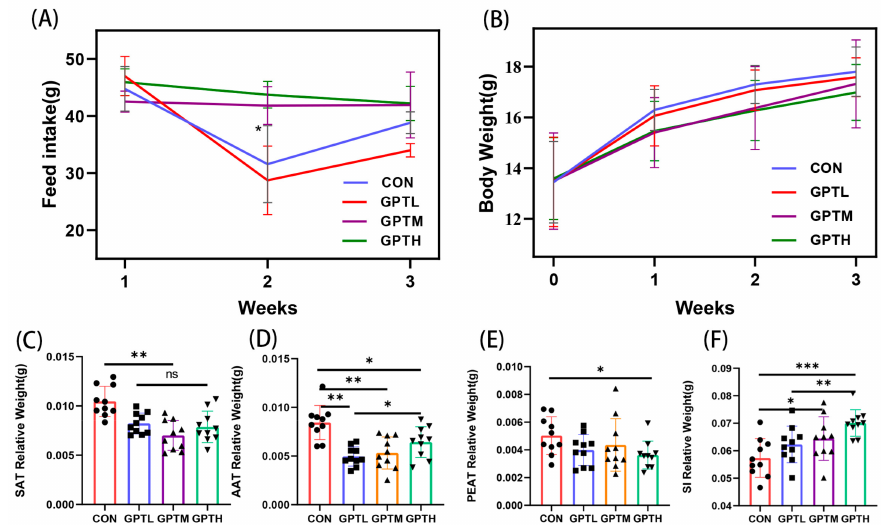
Figure 1. ( A ). Feed intake; ( B ). Body weight in mice for three weeks. ( C – F ): Effects of oral administra- tion of Control group (CON), Low Concentration Ganpu tea group (GPTL), Medium Concentration Ganpu tea group (GPTM) and High Concentration Ganpu tea group (GPTH) on the relative weight of adipose tissue and small intestine to body weight in mice ( n = 10, compared with each other